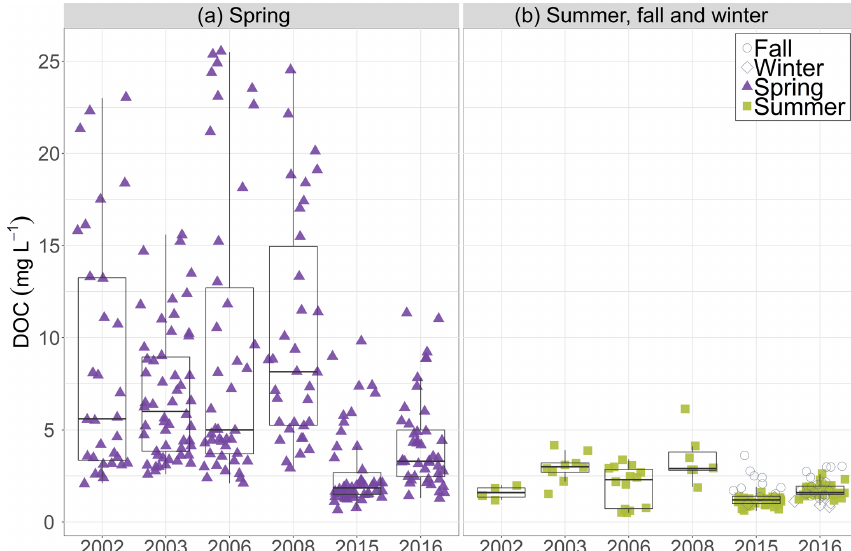
Figure 7. DOC concentration (in mgL − 1 ) is displayed on the y axis with panel (a) showing the DOC concentrations measured in 2002, 2003, 2006, 2008, 2015 and 2016 during spring (April 15 to June 14). Panel (b) displays DOC concentrations for the same years during summer (16 June to 15 August), fall (16 August to 15 October) and winter (16 October to 14 April). Season is additionally indicated by shape and colour (purple/filled triangle – spring; light green/filled square – summer; open circle – fall; open diamond – winter).